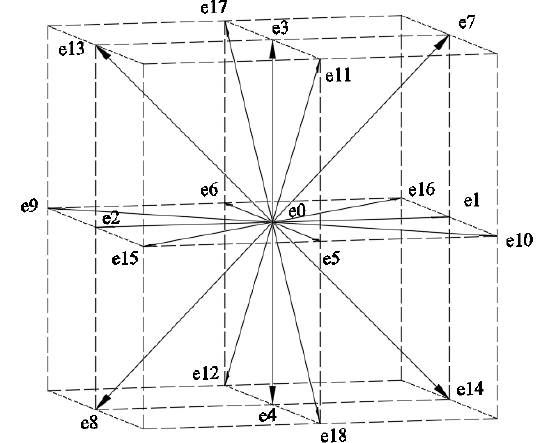
Figure 7. Discrete velocity diagram of lattice points.